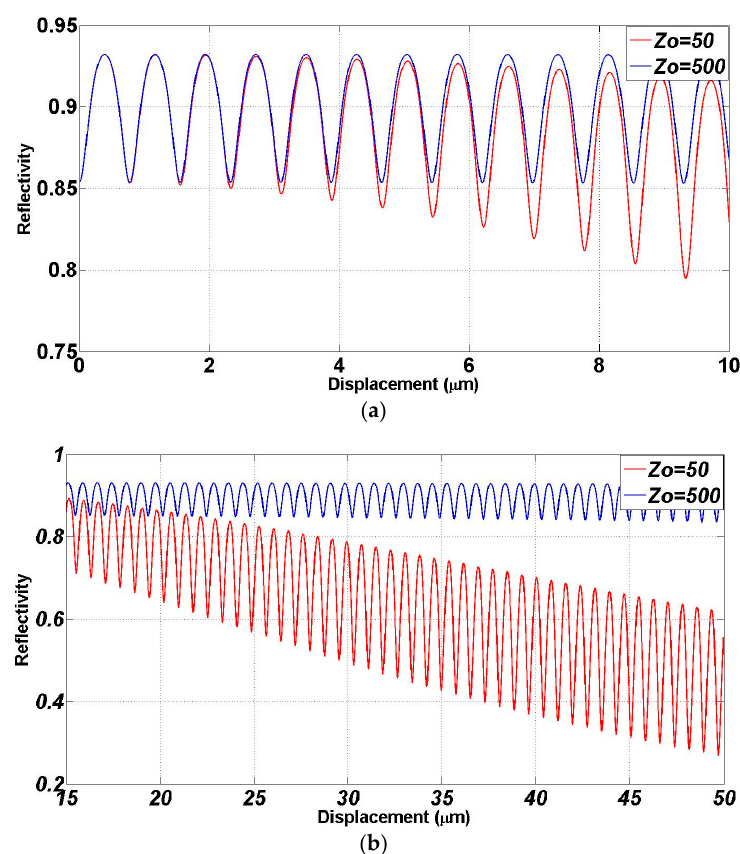
Figure 11. Simulated result of obtained interferogram suing the low-finesse Fabry-Perot using Gaussian beam with Rayleigh range z o of 50 and 500 μ m: ( a ) 10 μ m displacement of the micromirror in one direction; and ( b ) from 15 to 50 μ m motion